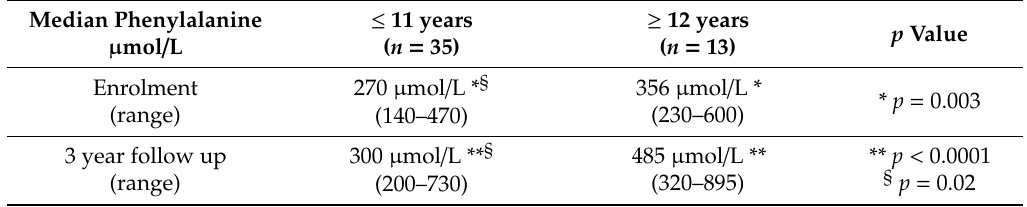
Table 4. Median (range) phenylalanine concentrations in children aged ≤ 11 years and ≥ 12 years at enrolment and follow up at 3